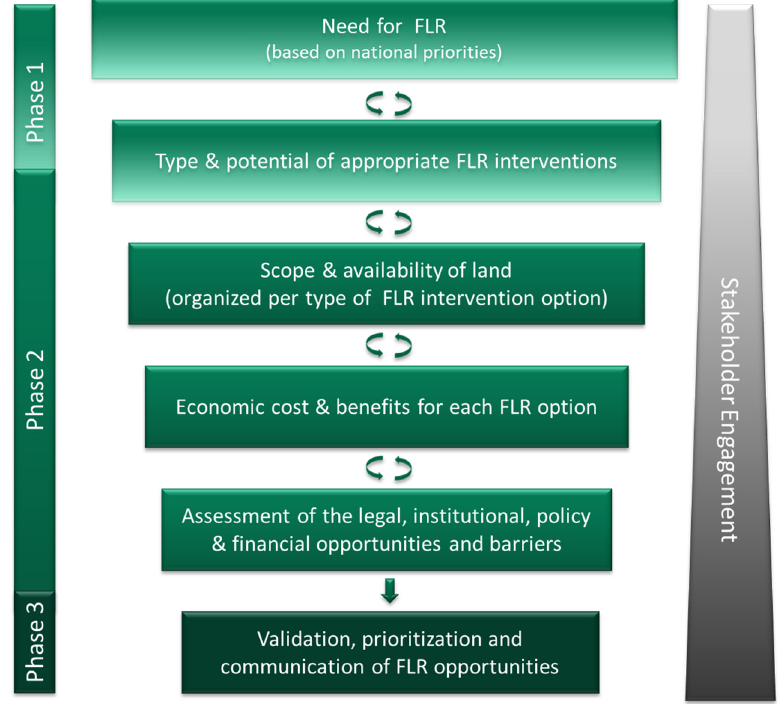
Figure 1. Forest Landscape Restoration (FLR) opportunity assessment with restoration opportunity assessment methodology (ROAM) [11].